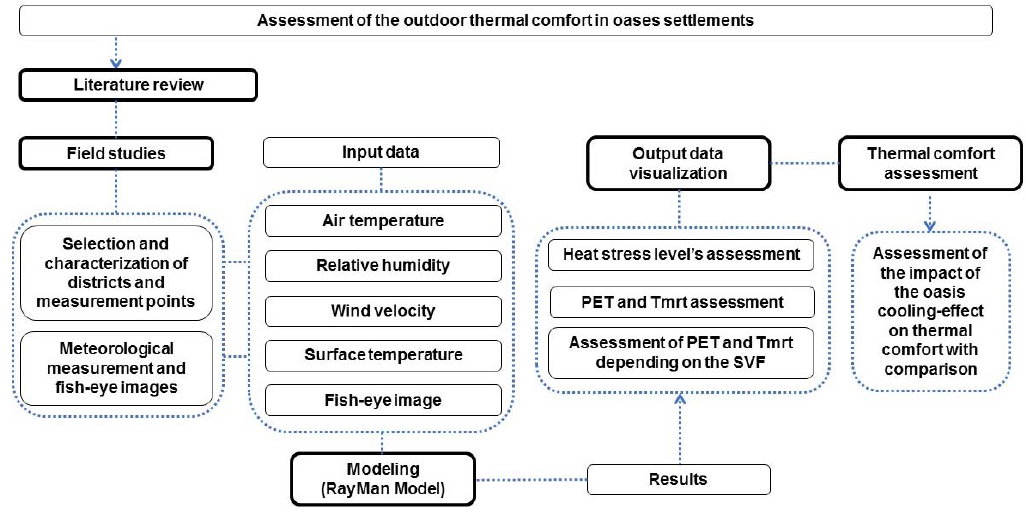
Figure 1. Conceptual study framework.